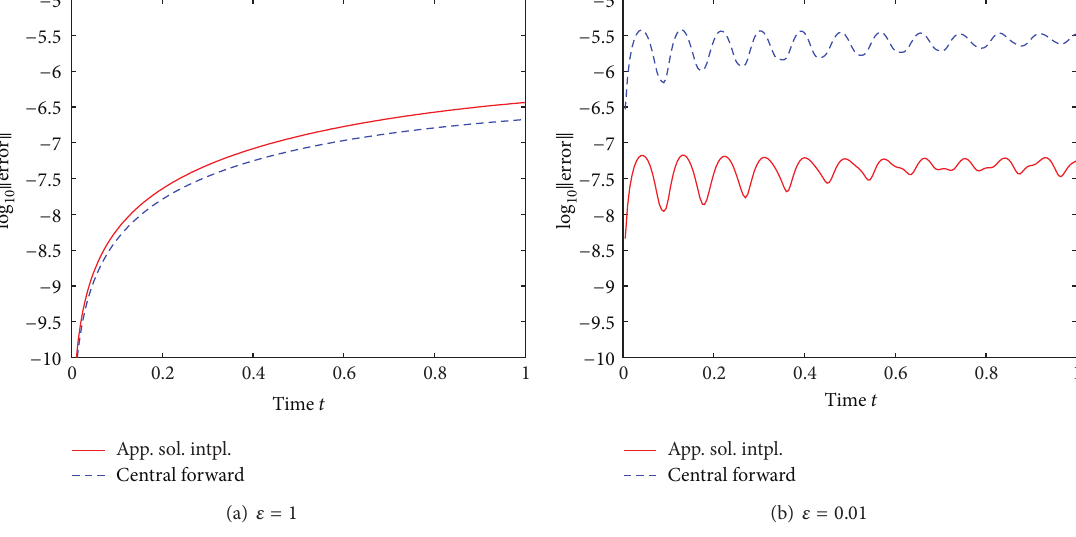
Figure 6: Time evolution of the errors in numerical solutions for 𝑢 𝑡𝑡 = (2 + sin (−𝑥/𝜀)) −1 𝑢 𝑥𝑥 , 0 ≤ 𝑥 ≤ 1 . The exact solution 𝑢 = (1 + 𝑥)𝑡 2 + 𝑥𝑡+ 𝑥 + 2(2𝜀 3 + 𝜀𝑥 + 𝑥 2 + 𝑥 3 /3 −2𝜀 3 cos (𝑥/𝜀) − 𝜀 2 (1+ 𝑥) sin (𝑥/𝜀)) is used to generate the initial/boundary conditions and measure the errors. in comparison to the conventional schemes. Consistency